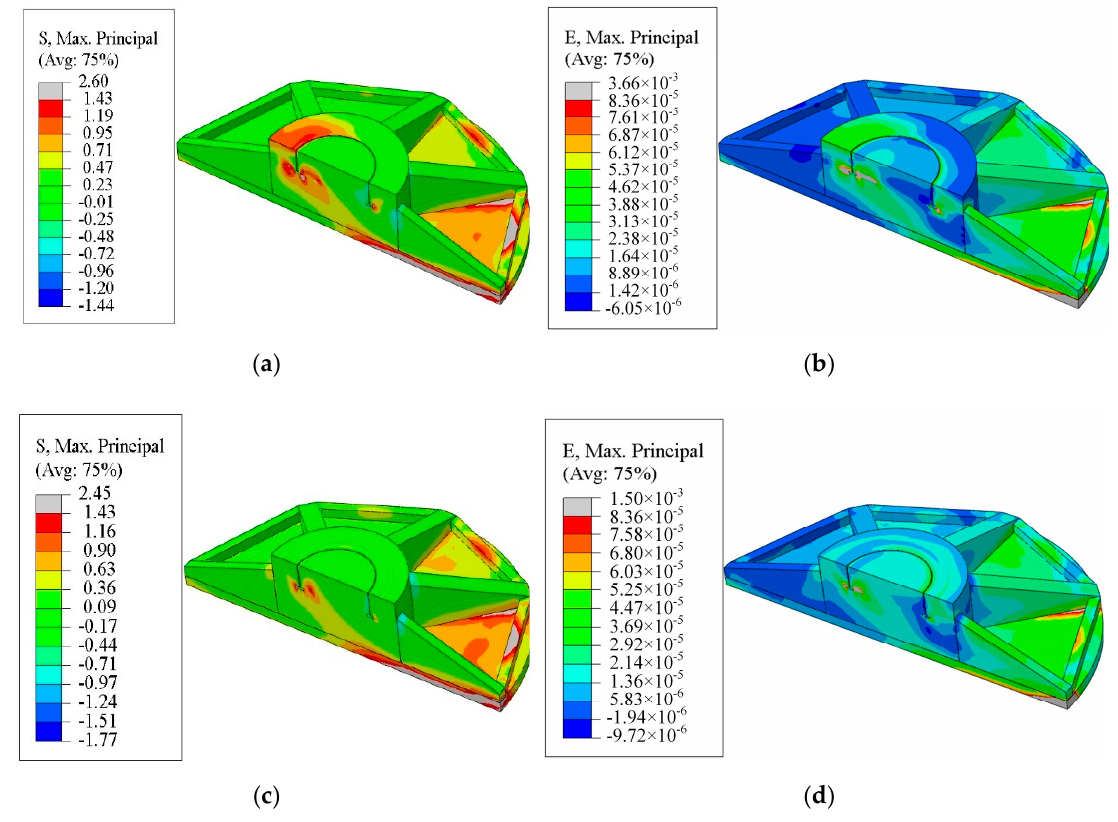
Figure 12. Maximum principal stress and strain of the foundation concrete before and after strengthening under normal operational case. ( a ) Maximum principal stress before strengthening; ( b ) Maximum principal strain before strengthening; ( c ) Maximum principal stress after strengthening; ( d ) Maximum principal strain after strengthening.